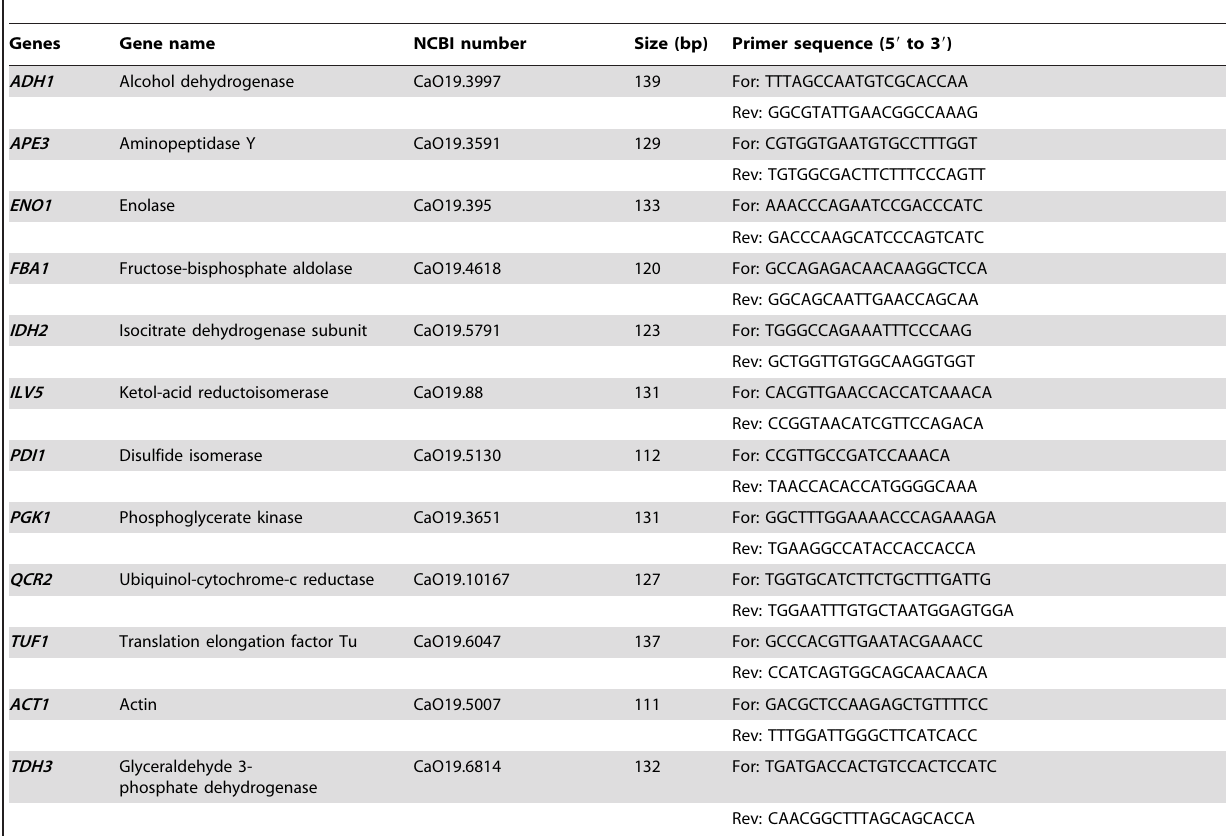
Table 1. PCR primers used for the analysis of gene expression by quantitative real time PCR.